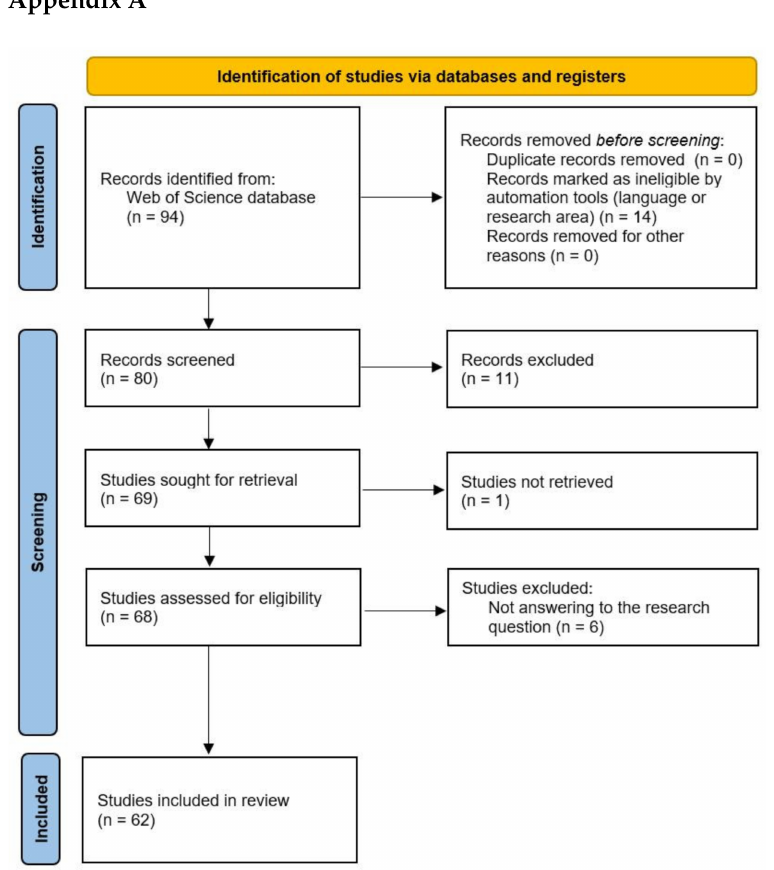
Figure A1. PRISMA flowchart depicting the inclusion/exclusion and screening process. Adapted with permission from PRISMA Website [82].